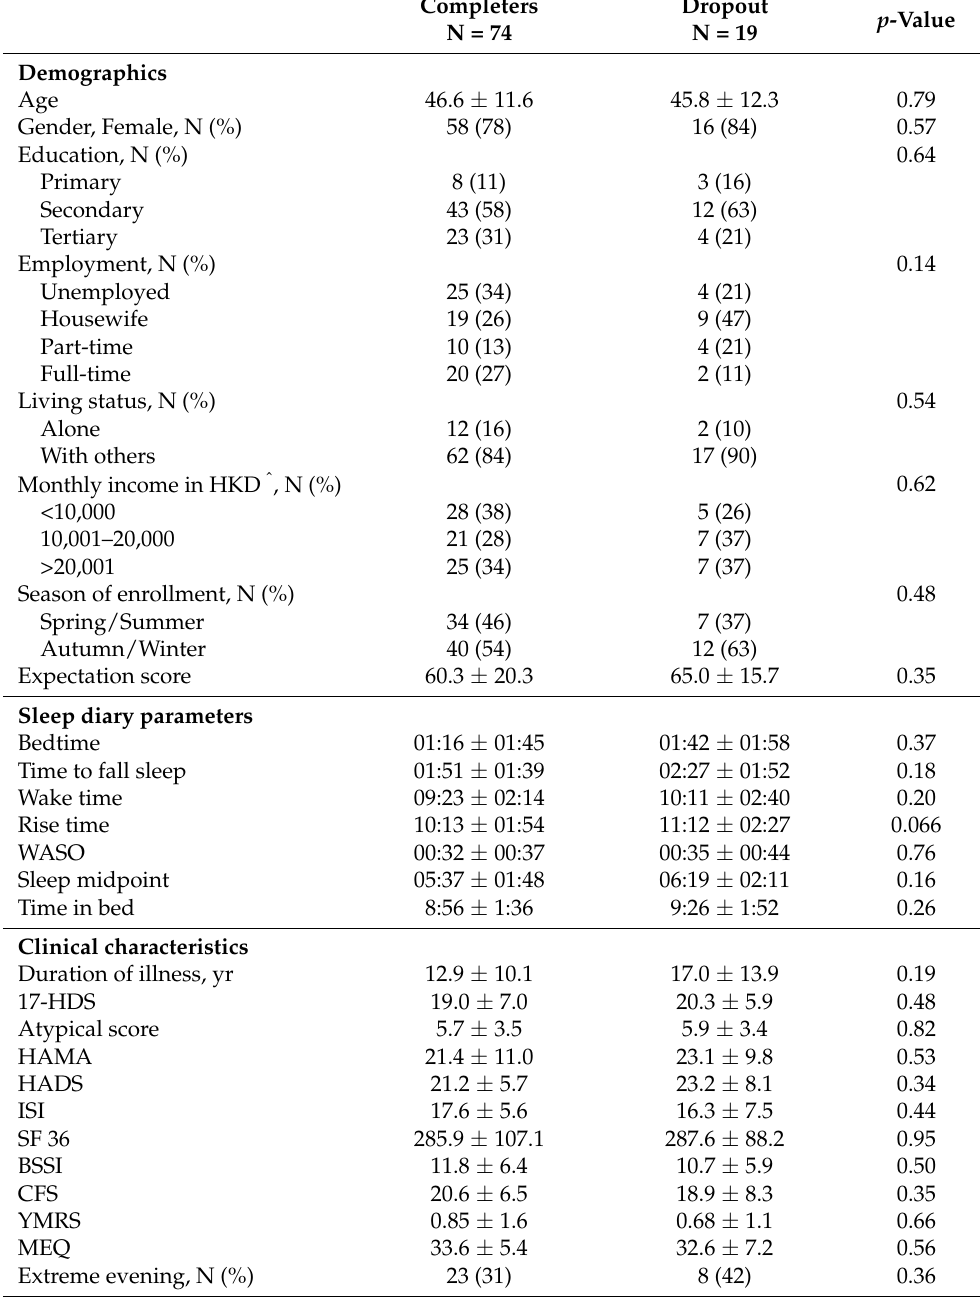
Table 1. Baseline demographics and clinical characteristics of the Dropout group versus the Completer group (means ± standard